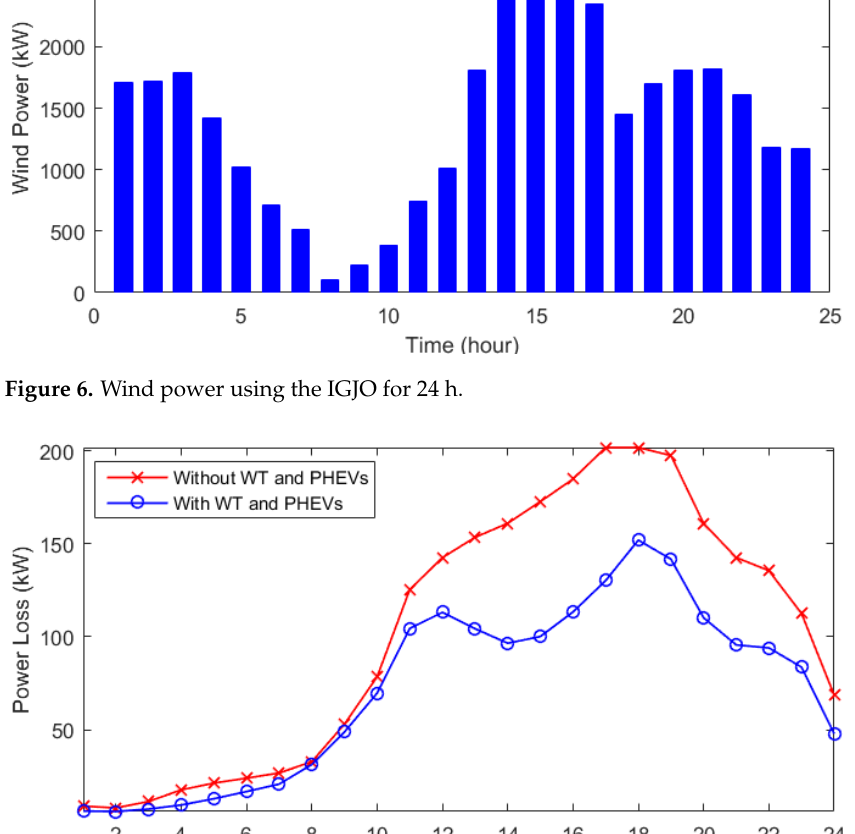
Figure 8. Received grid power with and without WT and PHEVs using the IGJO for 24 h. Figure 9. Minimum voltage of a 33-bus distribution network with and without WT and PHEVs using the IGJO for 24 h.